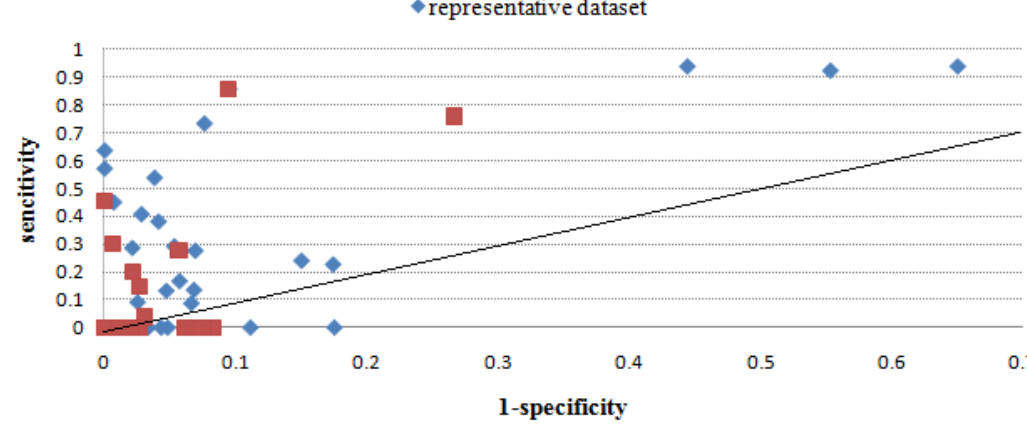
Figure 2. Sensitivity vs. 1-specificity scores of Mapitope on the benchmark dataset and the representative dataset.